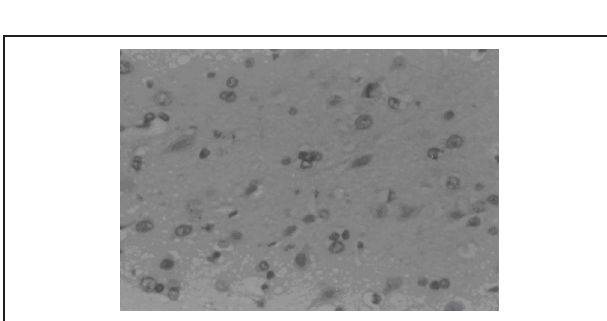
FIGURE 5 | TUNEL findings of GDNF + MSCs group at 28 days after transplantation.